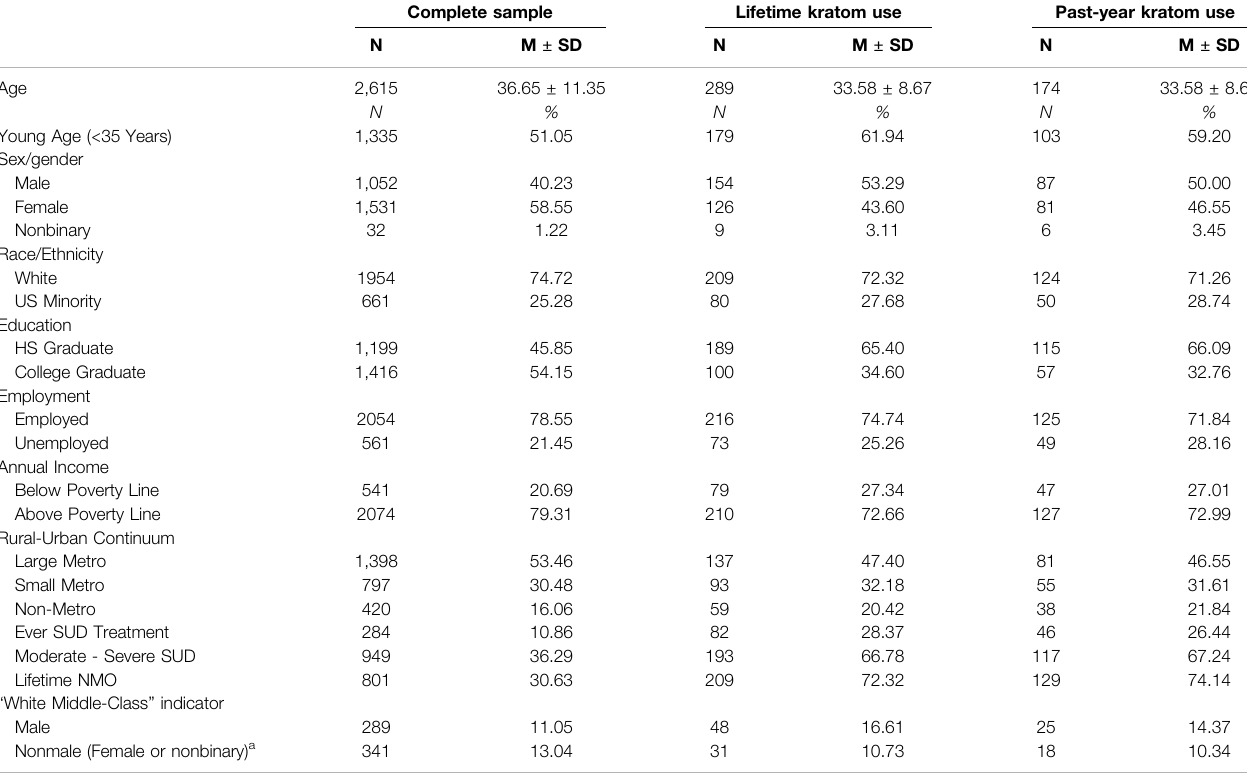
TABLE 1 | Demographics for our online crowdsourced sample, by lifetime and past-year kratom